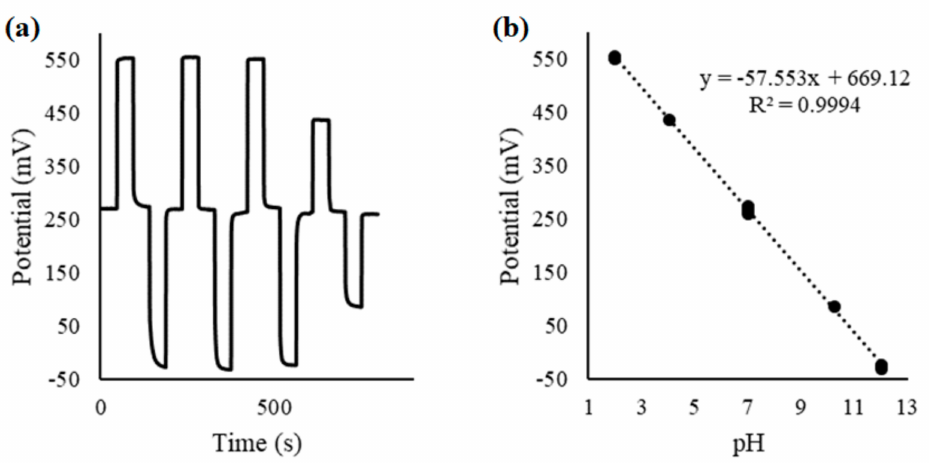
Figure 6. Electric potential recorded vs. a Ag | AgCl | KCl reference electrode for the potentiometric RuO 2 electrode on polyimide substrate, in pH 2, 4, 7, 10, and 12 bu ff ers ( a ); and the reversible linear Nernstian pH response of the electrode ( b ).